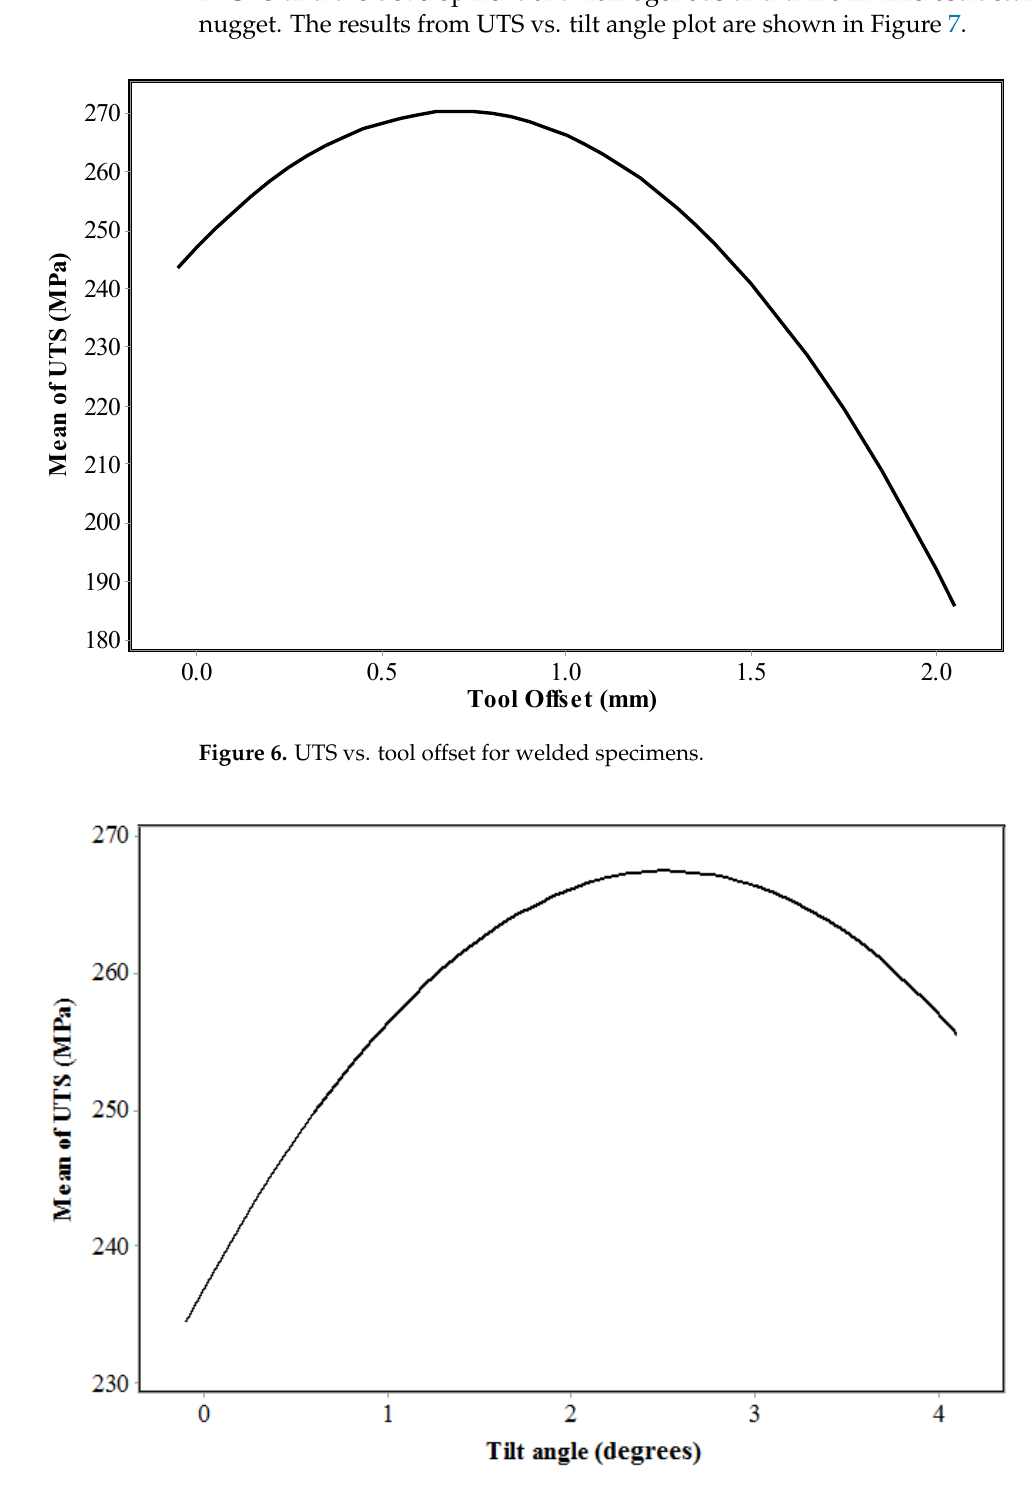
Figure 7. UTS vs. tool tilt angle for welded specimens.